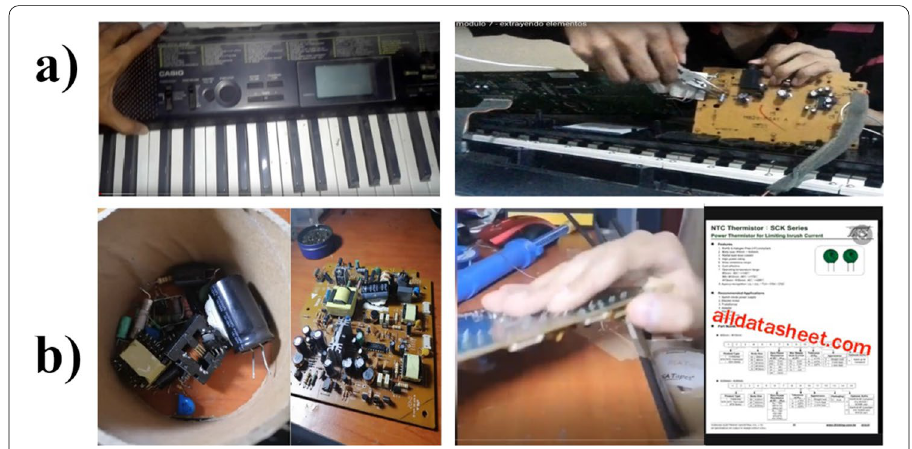
Fig. 15 Images of a video of the activity: “Recycling the WEEEs.” In this case, two examples of other WEEEs, apart from the UPS delivered for the activity. a An electronic musical instrument. b An audio